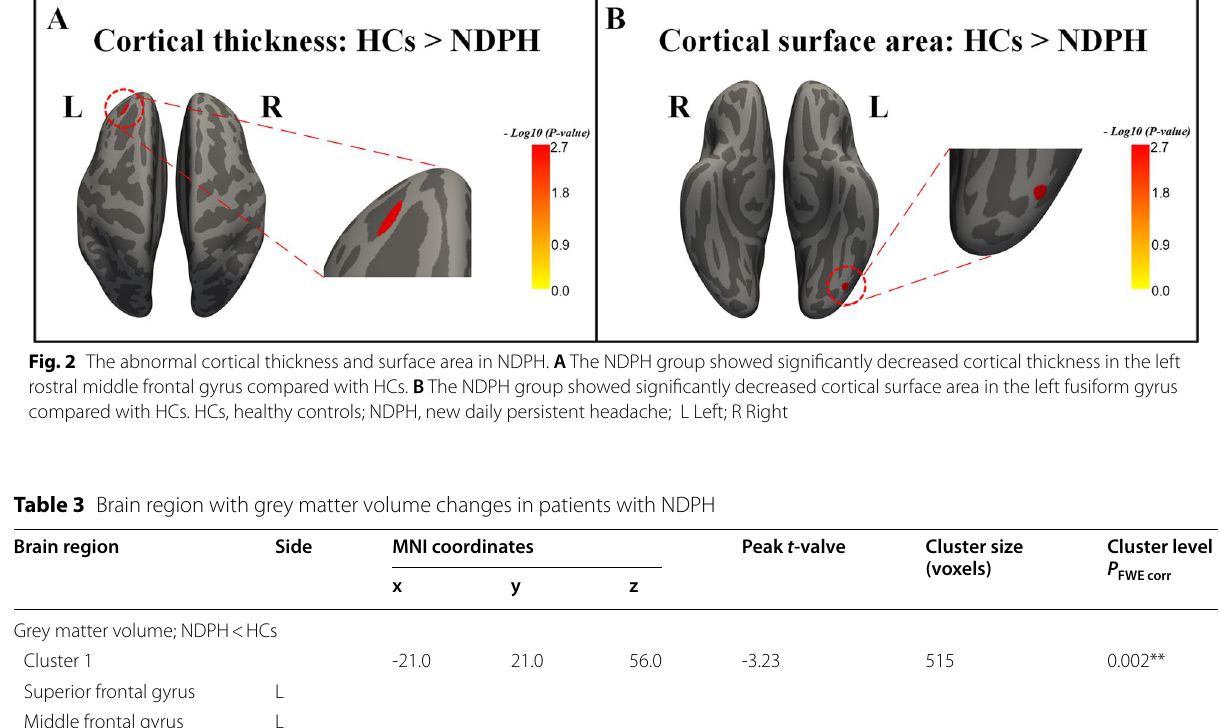
Brain region localizations were performed using Desikan-Killiany atlas MNI Montreal Neurological Institute; HCs Healthy controls; NDPH New daily persistent headache; L Left; CWP Cluster-wise corrected p -value **, p < 0.01